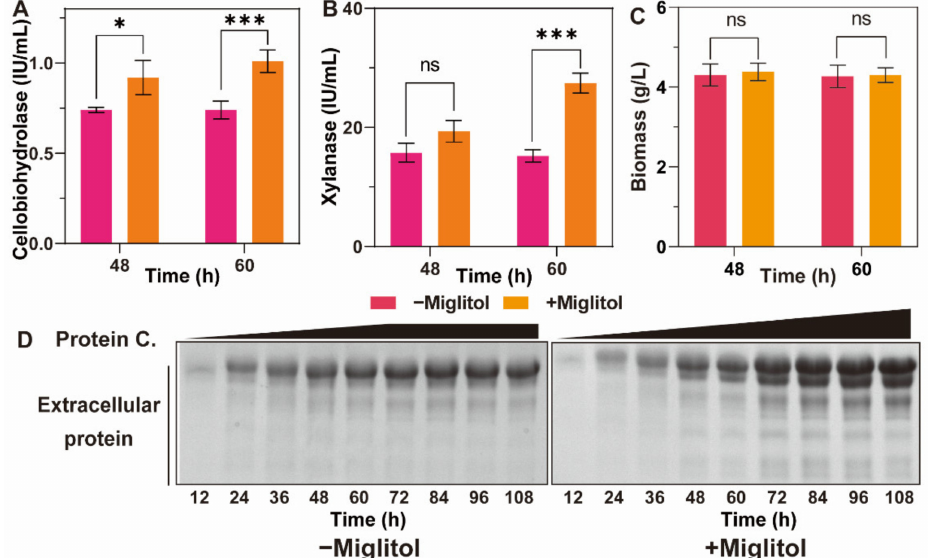
Figure 6. Effect of miglitol on lignocellulase production of T. reesei Rut C30 with 10 g/L MGD as the carbon source at 48 h and 60 h (( A ) Cellobiohydrolase; ( B ) Xylanase; ( C ) Biomass); ( D ) SDS-PAGE analysis of supernatant. Values are the mean ± SD of the results from three independent experiments. Asterisks indicate a significant difference (* p < 0.05, *** p < 0.01, Student’s t